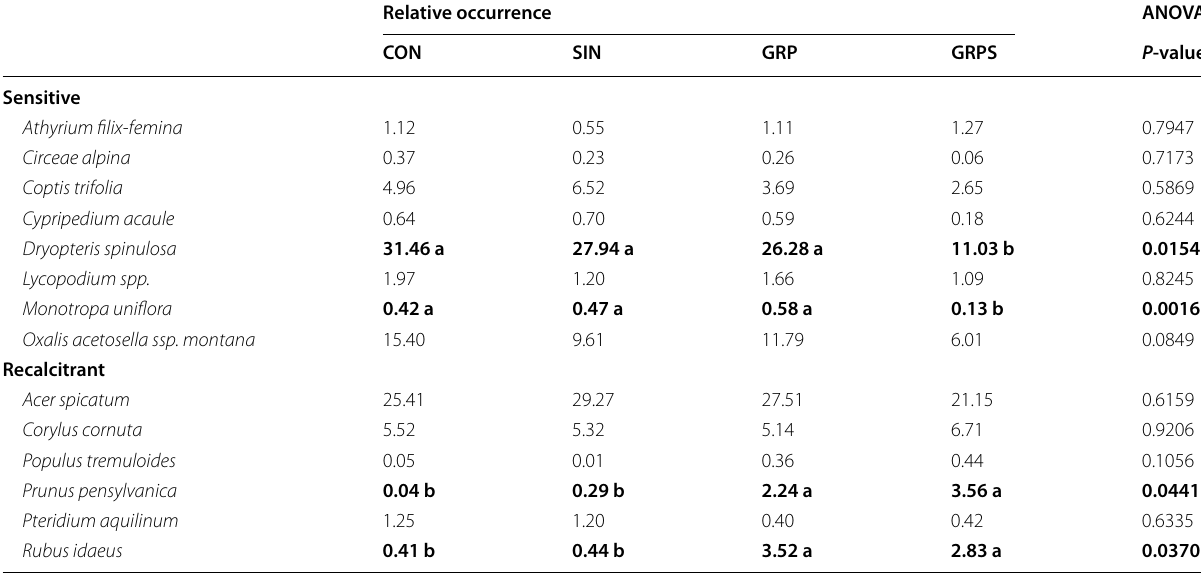
Mean relative occurrence values (%) are presented and two-way permutation ANOVA P -values. Significant treatment effects are represented by a P -value in bold ( P < 0.05). Within rows, means followed by the same letter do not differ significantly from one another at α